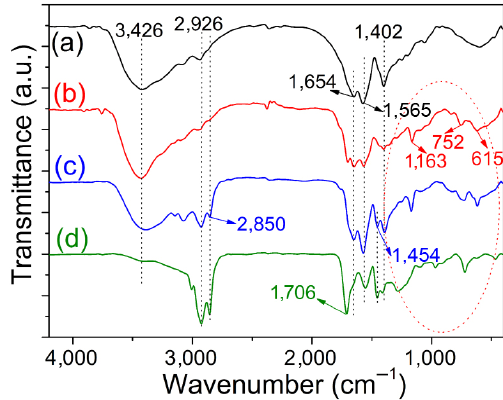
Fig. 4 FTIR spectra of (a) CNPs-Na, (b) CNPs-Cl, (c) A-g-CNPs, and (d) C-g-CNPs.